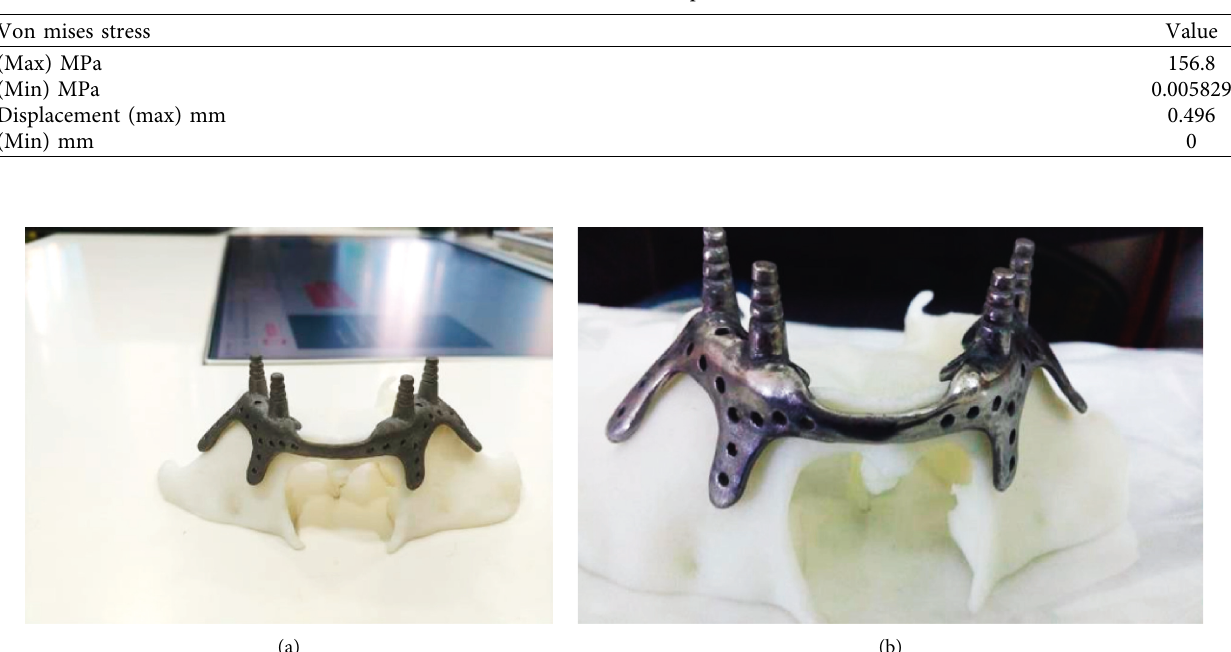
Figure 4: (a) Stress distribution in the implant (b) displacement in the implant. Table 3: Von-mises stress and displacement results.